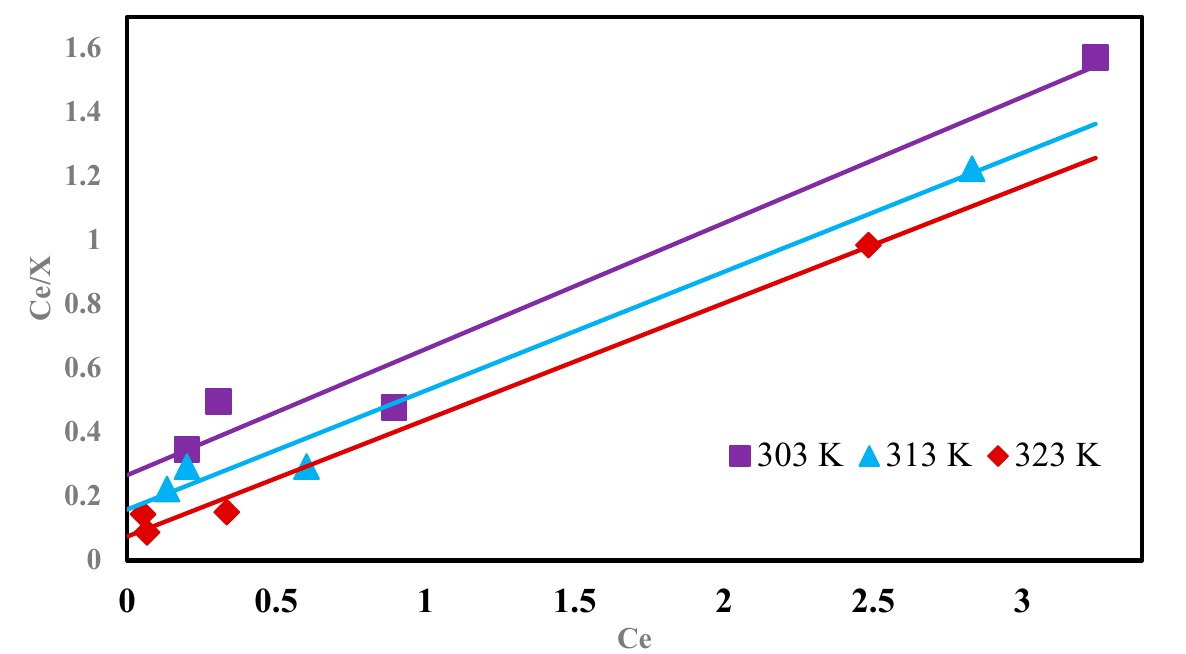
Figure 10. Langmuir plot of arsenate adsorption on MgO-IBC composite. Table 3. Comparison of the adsorption capacities of different adsorbents for arsenic.